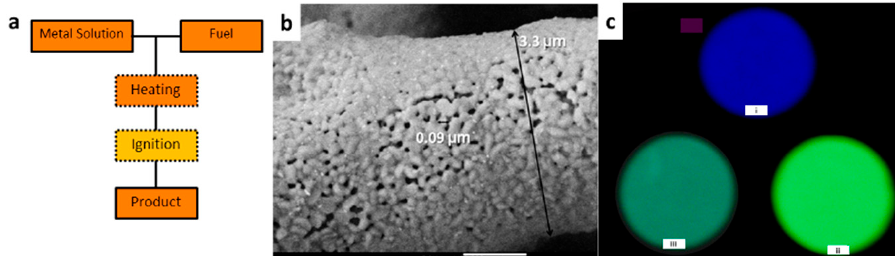
Figure 10. ( a ) Schematic flowchart of combustion synthesis (CS), and ( b ) SEM image of BaAl 2 O 4 :Eu 2+ , Dy 3+ prepared using the CS method. Reproduced from [191] with permission from Elsevier. ( c ) Picture of the PeL emission of MAl 2 O 4 :Eu 2+ ,RE 3+ (M: (i) Ca 2+ , (ii) Sr 2+ or (iii) Ba 2+ ) prepared using the CS method. Reproduced from [215] with permission from Elsevier.